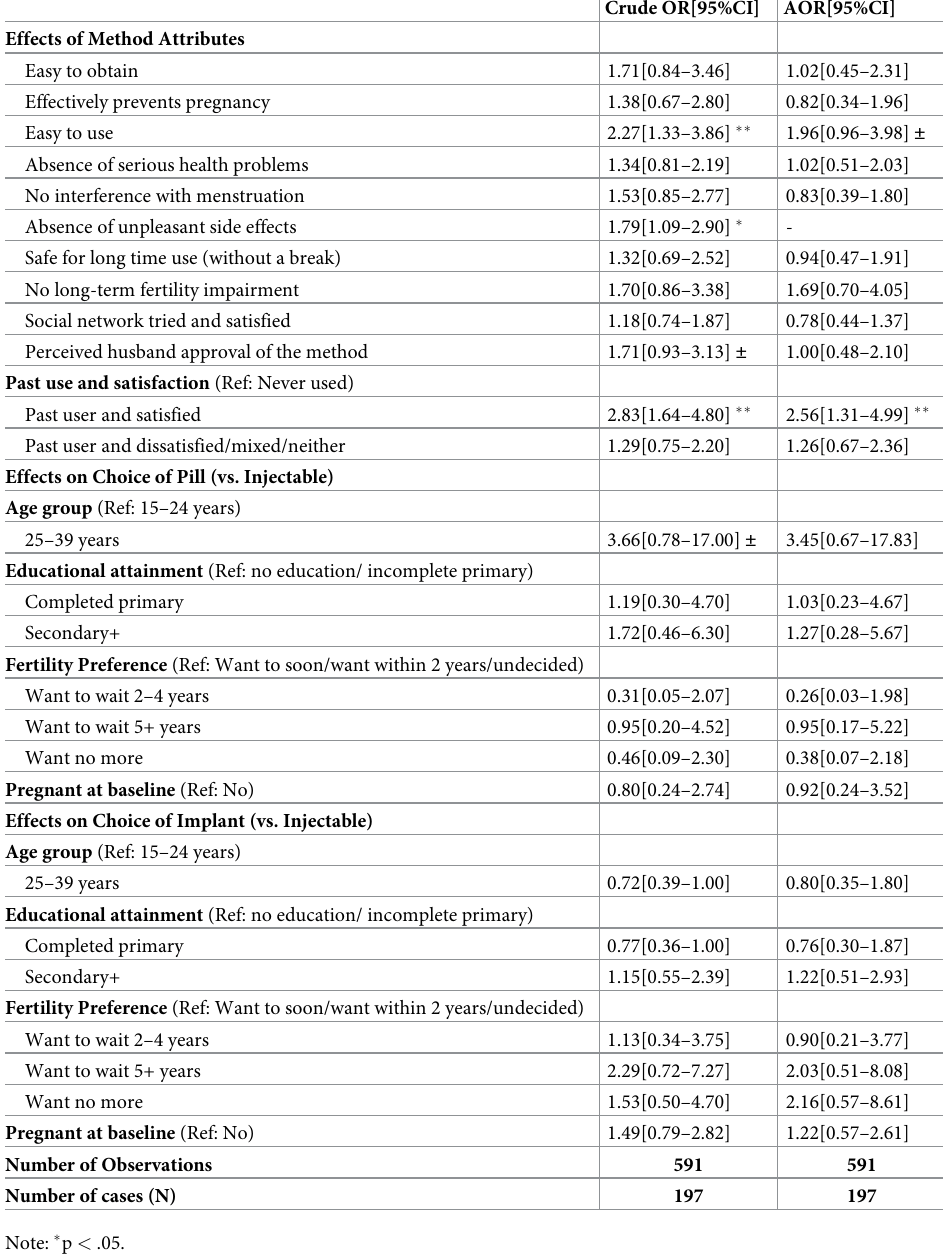
Table 4. Odds ratios (and 95% confidence intervals) from conditional logit regression analyses assessing women’s likelihood of using injectable, pill or implants at 12-month follow-up by perceived method attributes, past use and satisfaction, and selected characteristics-Homa